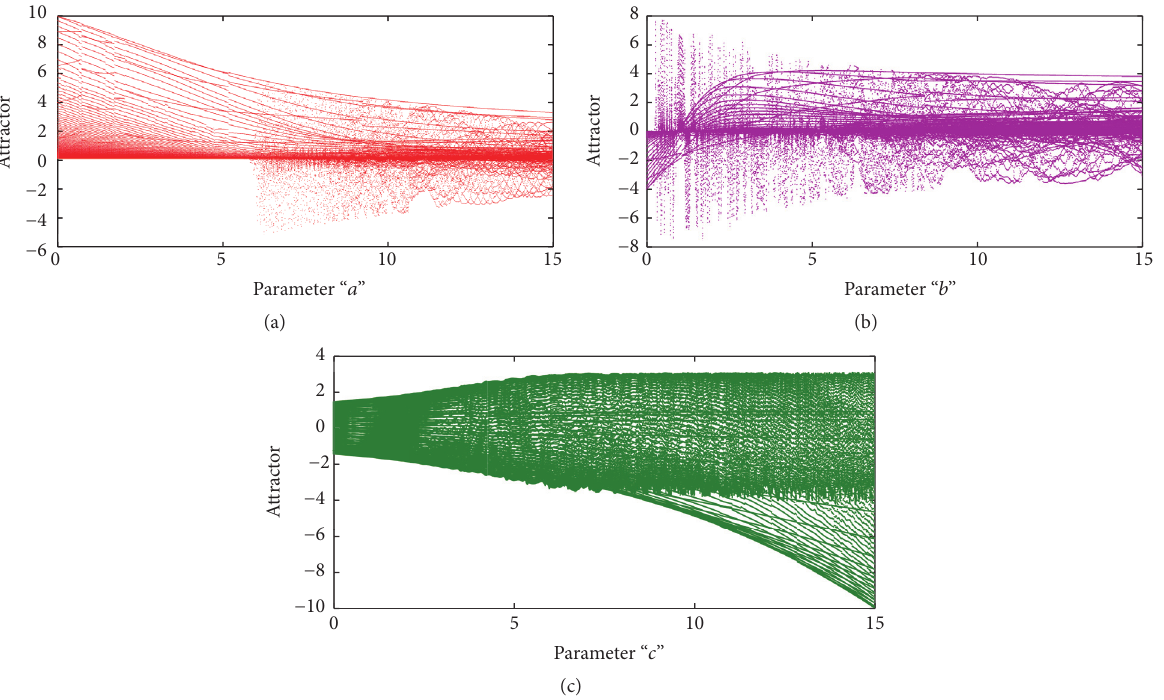
Figure 2: (a) Bifurcation plot versus 𝑎 . (b) Bifurcation plot versus 𝑏 . (c) Bifurcation plot versus 𝑐 .